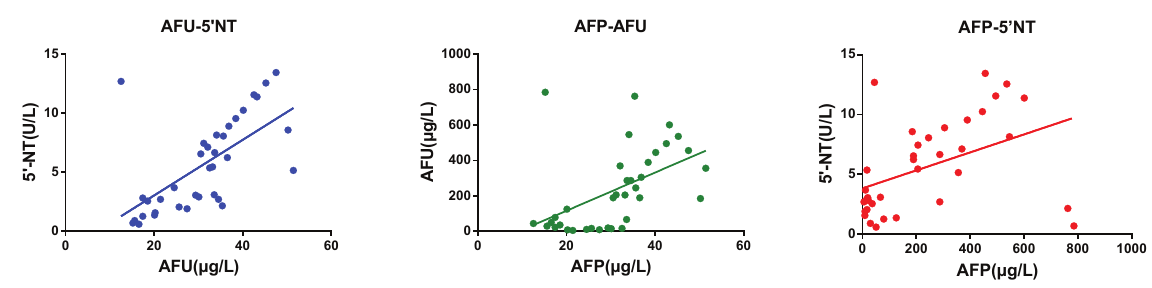
Figure 3: The scatter plot of correlation between serum AFU, 5’-NT and AFP in hepatocellular carcinoma